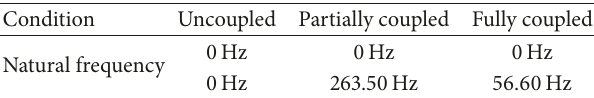
Table 4: Comparisons of the two zero frequencies under different